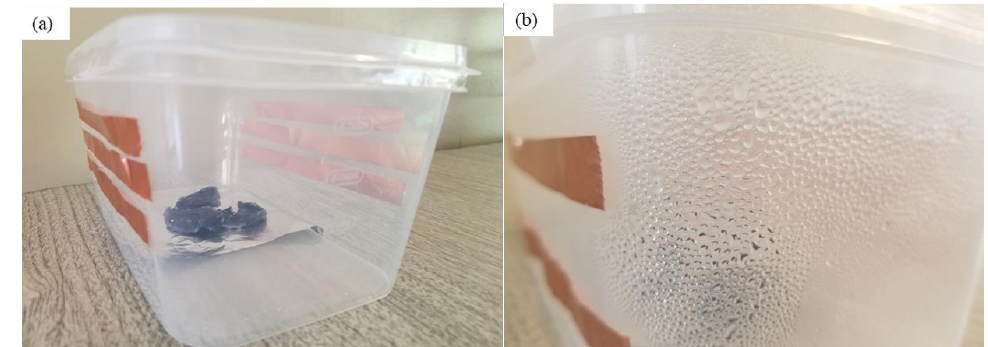
Figure 10. Digital photos of water collection: ( a ) device prototype based on PAN/AM/graphene/CaCl 2 hydrogel; and ( b ) condensed water on the wall of the box during the collection process.